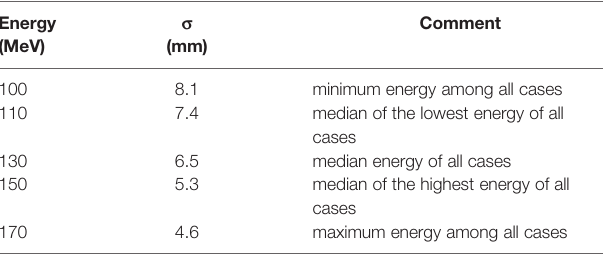
TABLE 1 | Pencil-beam scanning in-air spot characteristics of the treatment plans of the current study.